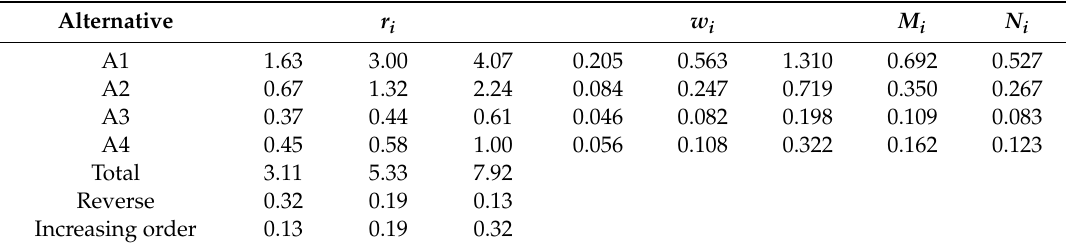
Table 14. Results of r i , W i , M i and N i in respect to the budgetary constraints.